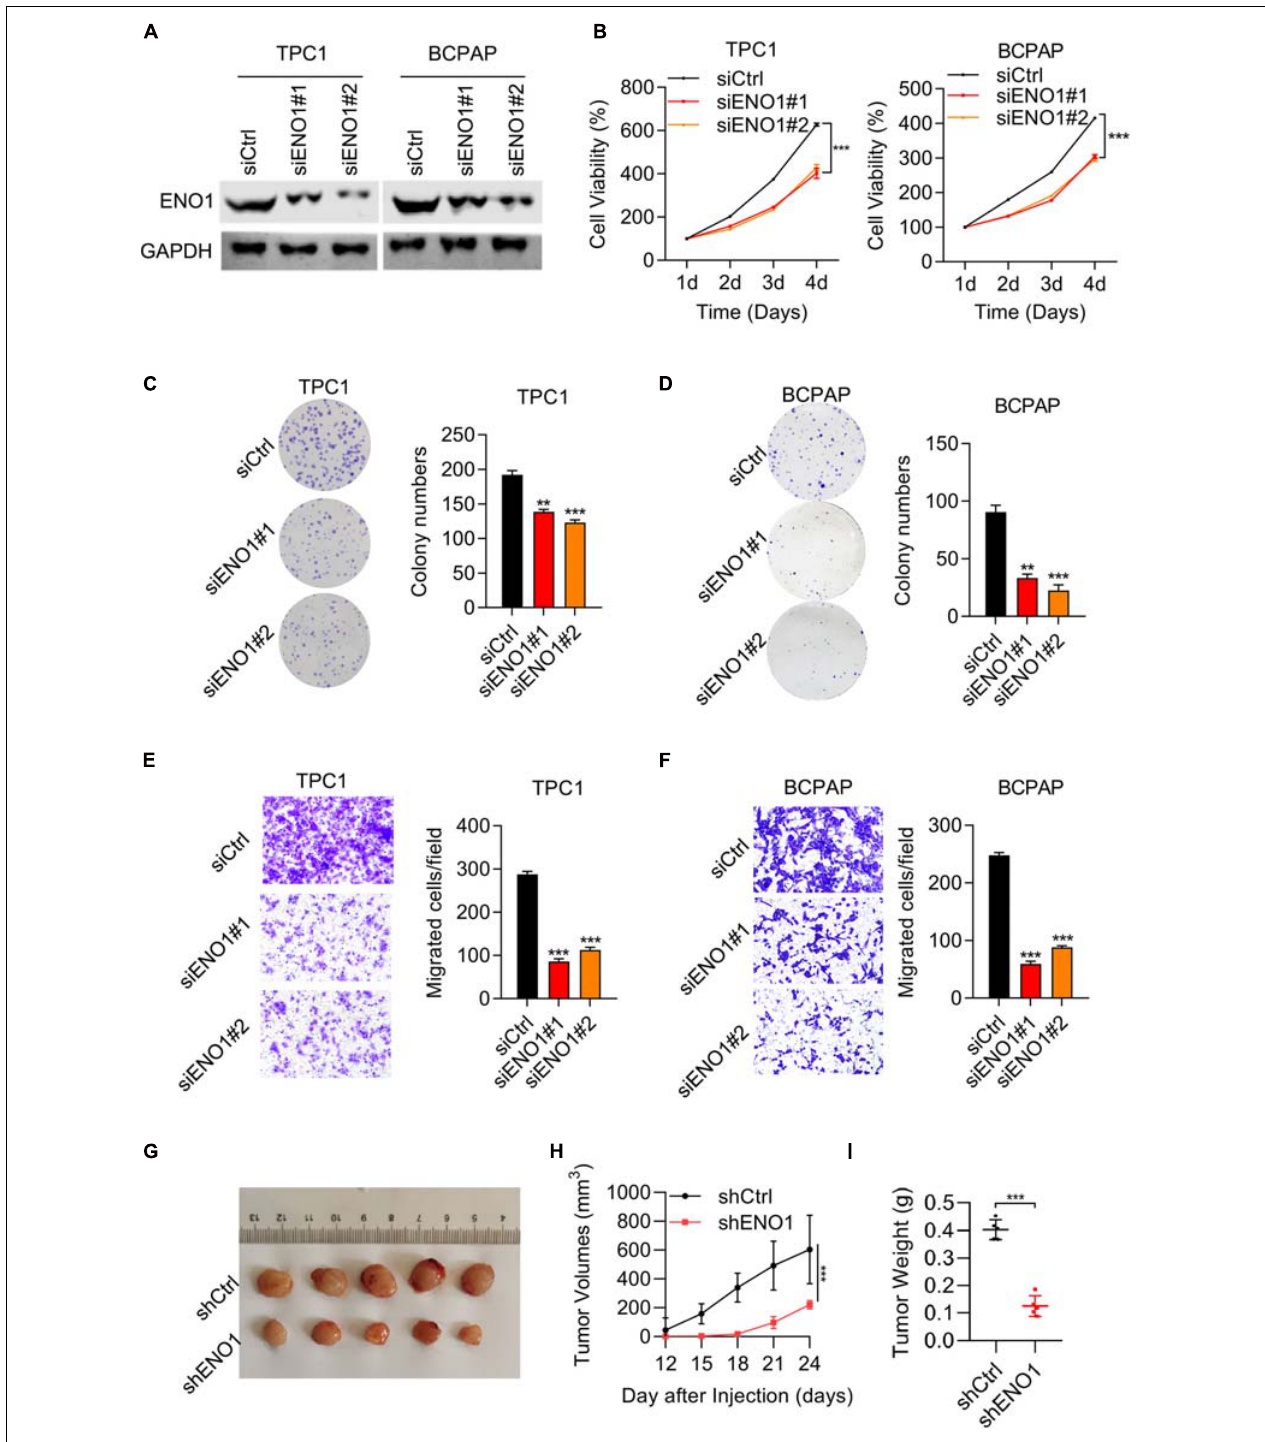
FIGURE 2 | Downregulation of ENO1 suppresses cell proliferation, invasion, and in vivo tumorigenicity. (A) Western blotting analysis of ENO1 knockdown efficiency in TPC1 and BCPAP cells. GAPDH was used as a loading control. (B) CCK8 analysis of cell proliferation in TPC1 cells and BCPAP cells transfected with siCtrl, siENO1#1, and siENO1#2. (C,D) Colony formation assay in TPC1 (C) and BCPAP (D) cells transfected with siCtrl, siENO1#1, and siENO1#2. * P < 0.05, ** P < 0.01, *** P < 0.001. (E,F) Transwell invasion analysis in TPC1 (E) and BCPAP (F) cells transfected with siCtrl, siENO1#1, and siENO1#2. *** P < 0.001. (G–I) Athymic nude mice ( n = 5) injected with TPC1 cell lines expressing shCtrl or shENO1 were analyzed for tumor formation. Representative image (G) , tumor growth curve (H) and weight (I) of xenografted tumors are shown.